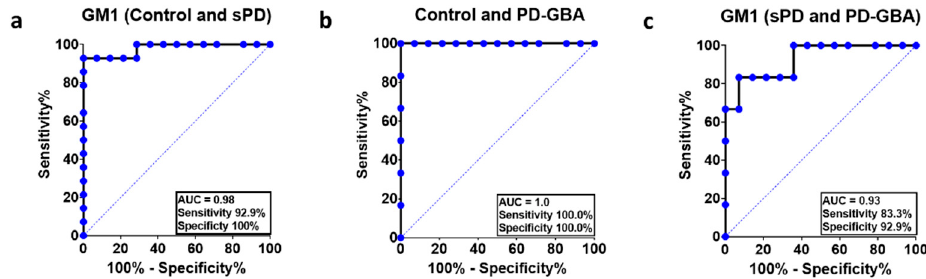
Figure 4. ROC curves of GM1 in PBMCs measured using the modified analytical method. The ROC curves were used to determine the probability of differentiating sPD ( a ) and PD-GBA ( b ) patients from controls; and PD-GBA patients from sPD patients ( c ) using GM1 expression levels in PBMCs. The area under the curve (AUC) and the sensitivity (%) and specificity (%) for cutoff levels are indicated on the plots.